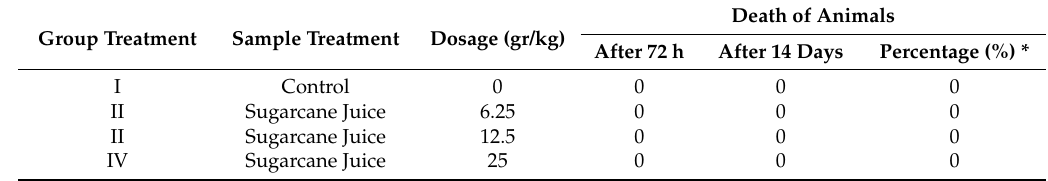
Table 2. Acute toxicity study in mice.